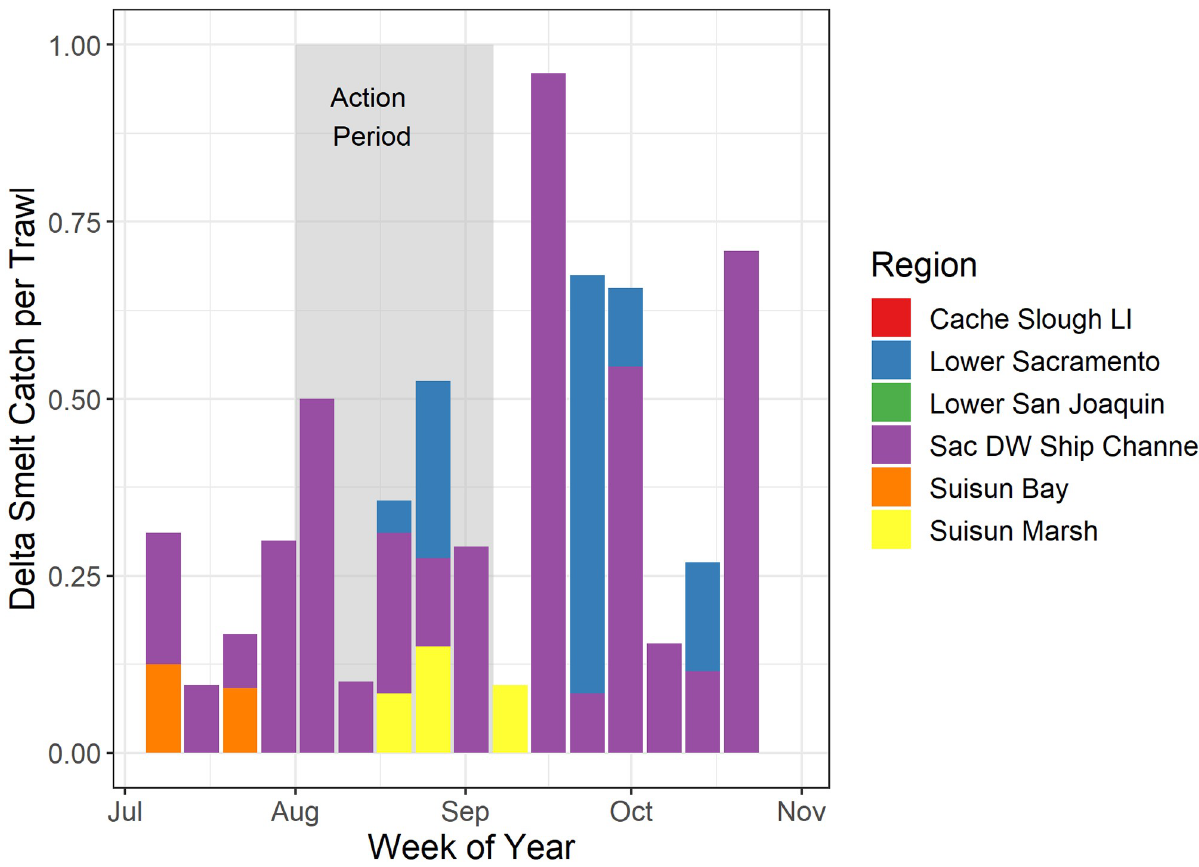
Fig 10. Catch-per-unit-effort (CPUE–catch/tow) of Delta Smelt across six different regions of the upper estuary during summer and fall 2018. The period of the Flow Action is highlighted. Details about the survey and locations are summarized in USFWS, 2019 [41].